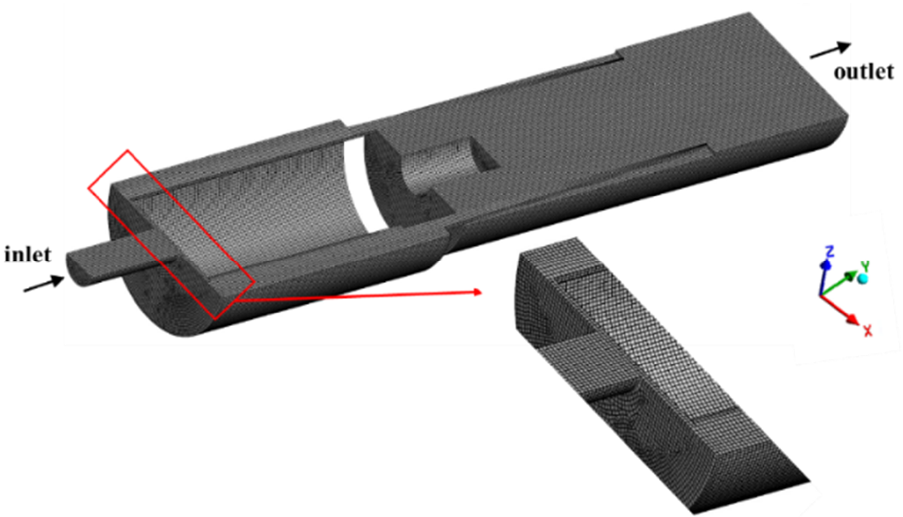
Figure 4. The mesh of flow domain.